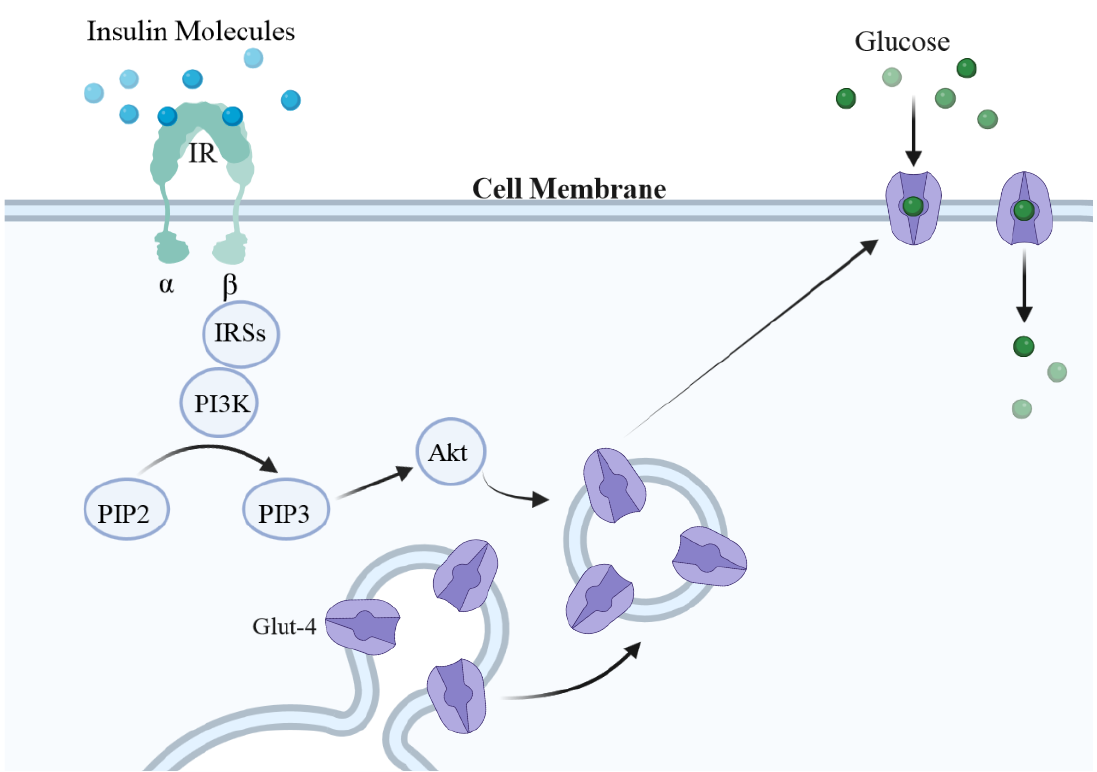
Figure 1: Insulin signaling machinery in peripheral tissues (IR= insulin receptor, IRS= insulin receptor substrate, PI3K=phosphoinositide 3-kinase, PIP 3 =phosphatidylinositol 3,4,5-trisphosphate, Akt= protein kinase